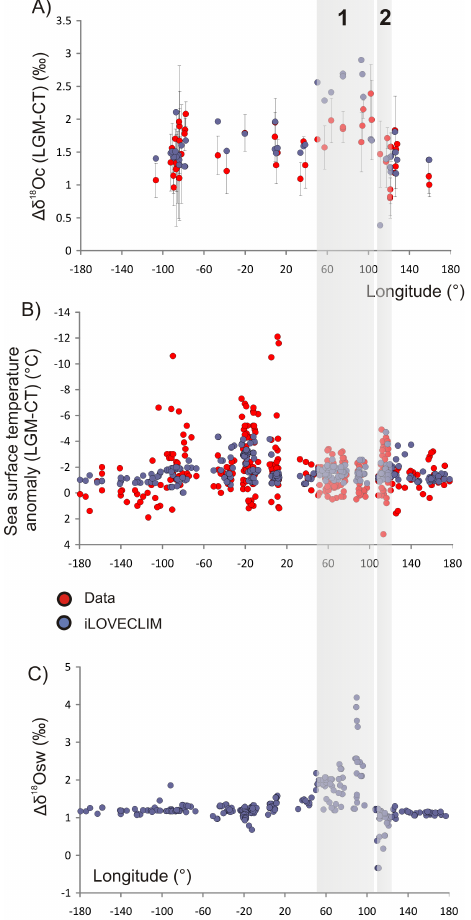
Figure 10. Data–model ( i LOVECLIM) comparison as a function of longitude in the tropical band (30 ◦ N–30 ◦ S) for (a) the surface ocean (0–50m) calcite δ 18 O anomaly (LGM-CT) and (b) sea sur- face temperature anomaly (LGM-CT). (c) Simulated surface water δ 18 O anomaly (LGM-CT) in i LOVECLIM as a function of longi- tude in the tropical area (30 ◦ N–30 ◦ S) (model results are taken at the same location as sea surface temperature data). Grey bands de- note large positive/negative calcite δ 18 O anomaly in (1) the North Indian Ocean and (2) the China Sea as discussed in the